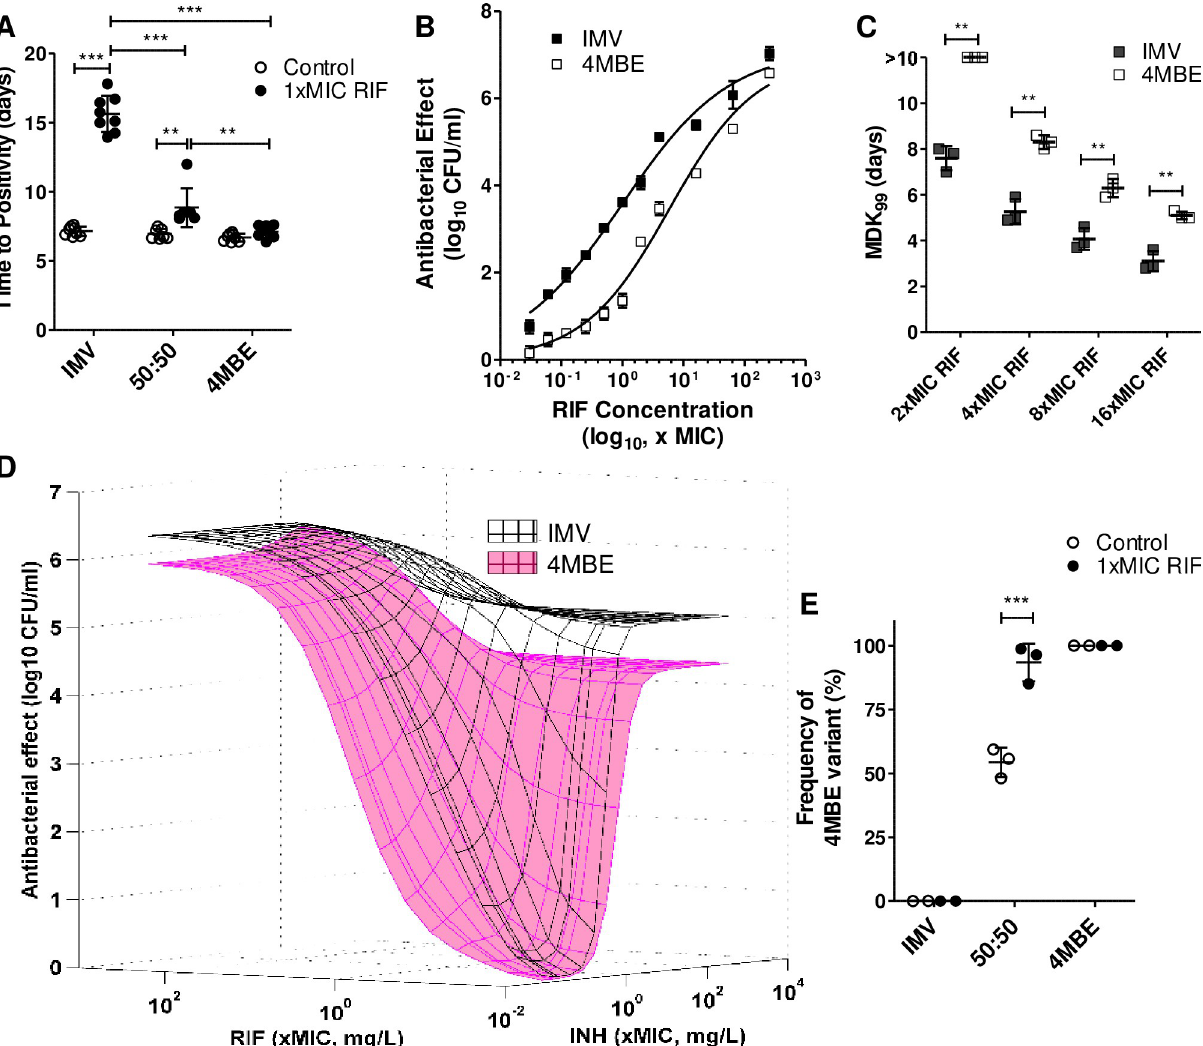
Fig 4. The 4MBE variant is tolerant to rifampicin (RIF) alone and in combination with isoniazid (INH). (A) Mycobacterial growth of the IMV, 4MBE variant, and a 50:50 mixture in absence (white; Ctrl, inoculated with 10 3 CFU/mL) or presence of RIF (black; 1x minimum inhibitory concentration (MIC) RIF, inoculated with 10 5 CFU/mL) is expressed in time to positivity (TTP) in the BACTEC system. Values for each condition are the mean ± standard deviation (SD) of seven or eight independent experiments. Means were compared using one-way ANOVA followed by Bonferroni correction. (B) Time-kill data were determined after 7 days of RIF exposure, at concentrations ranging from 1/32 to 256xMIC, for the IMV (black) and the 4MBE variant (white). Fit of the Hill pharmacodynamic model to rifampicin (RIF) time-kill data, the solid lines are the best fit lines. The y-axis represents the difference in log 10 CFU/mL relative to control (C = 0) from a duplicate experiment. ( C ) Inocula of IMV and 4MBE variant at 2.10 7 CFU/ mL were exposed to 2, 4, 8, and 16xMIC of RIF. Mycobacterial survival was determined at 3, 5, 7, and 10 days post-exposure by CFU counting. Variation in RIF tolerance was determined by the minimum duration for killing 99% of the mycobacterial population (MDK 99 ) time. Values for each condition are the mean ± SD of three independent experiments. Means were compared using Student’s t-test. (D) Superposition of response surface models of the combined antibacterial effect of INH and RIF, from 1/32 to 256xMIC, against the IMV (black) and the 4MBE variant (pink). A total of 142 measures of the effect of RIF and INH alone or in combination were performed, and results were analyzed using the Minto response surface model. The surfaces represent the model-based predicted effect, representing the antibacterial effect measured after 7 days of exposure. (E) After 4 weeks of incubation without (white; Ctrl) or with RIF (black; 1xMIC RIF), the change in the 4MBE variant frequency on plated bacteria was assessed by droplet digital PCR (ddPCR) as described in the Material and Methods section. Values for each condition are the mean ± standard deviation (SD) of two or three independent experiments. Means were compared using the Student’s t-test. � p < 0.05, �� p < 0.01, ��� p < 0.001.